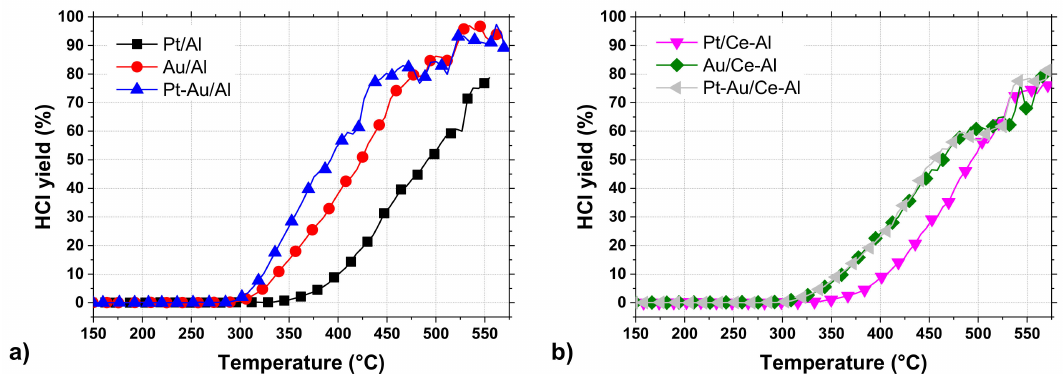
Figure 6. The HCl yields of the Pt, Au, and Pt-Au catalysts supported on ( a ) Al 2 O 3 and on